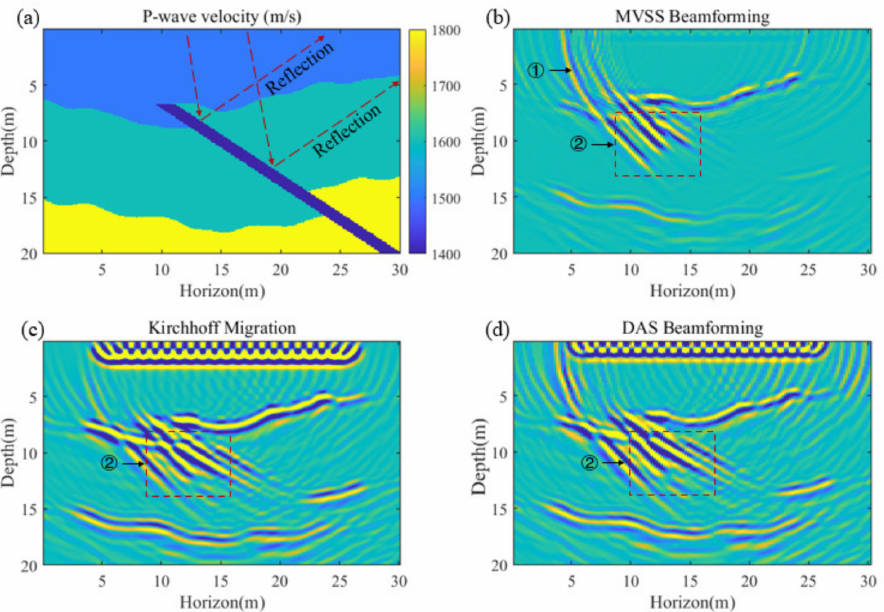
Figure 16. Model B-4b. ( a ) True velocity model. ( b ) Imaging result of MVSS beamforming. ( c ) Imaging result of Kirchhoff migration. ( d ) Imaging result of DAS